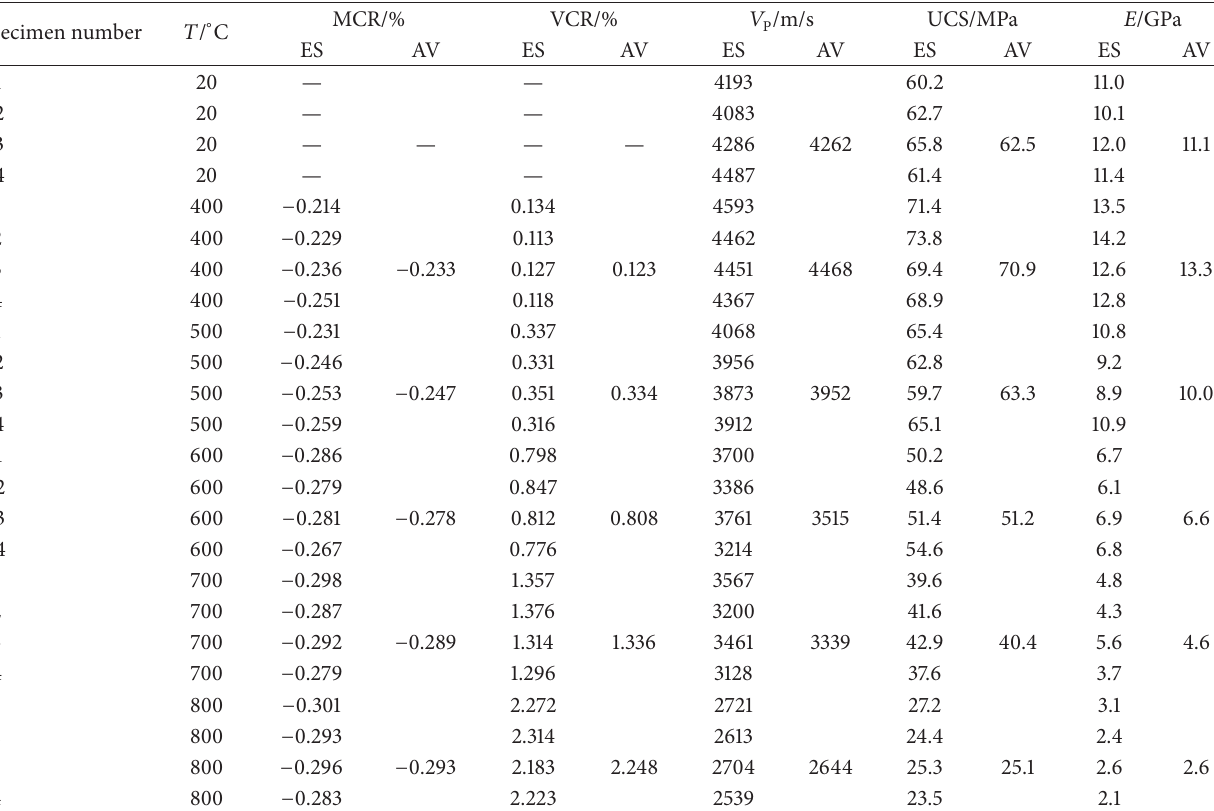
Table 1: Characteristics of damaged specimens after high-temperature